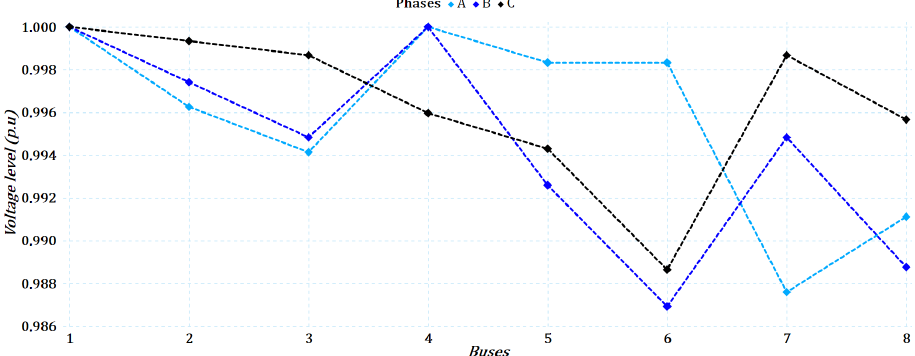
Figure 7. Node voltage profiles for the 8-bus IEEE system